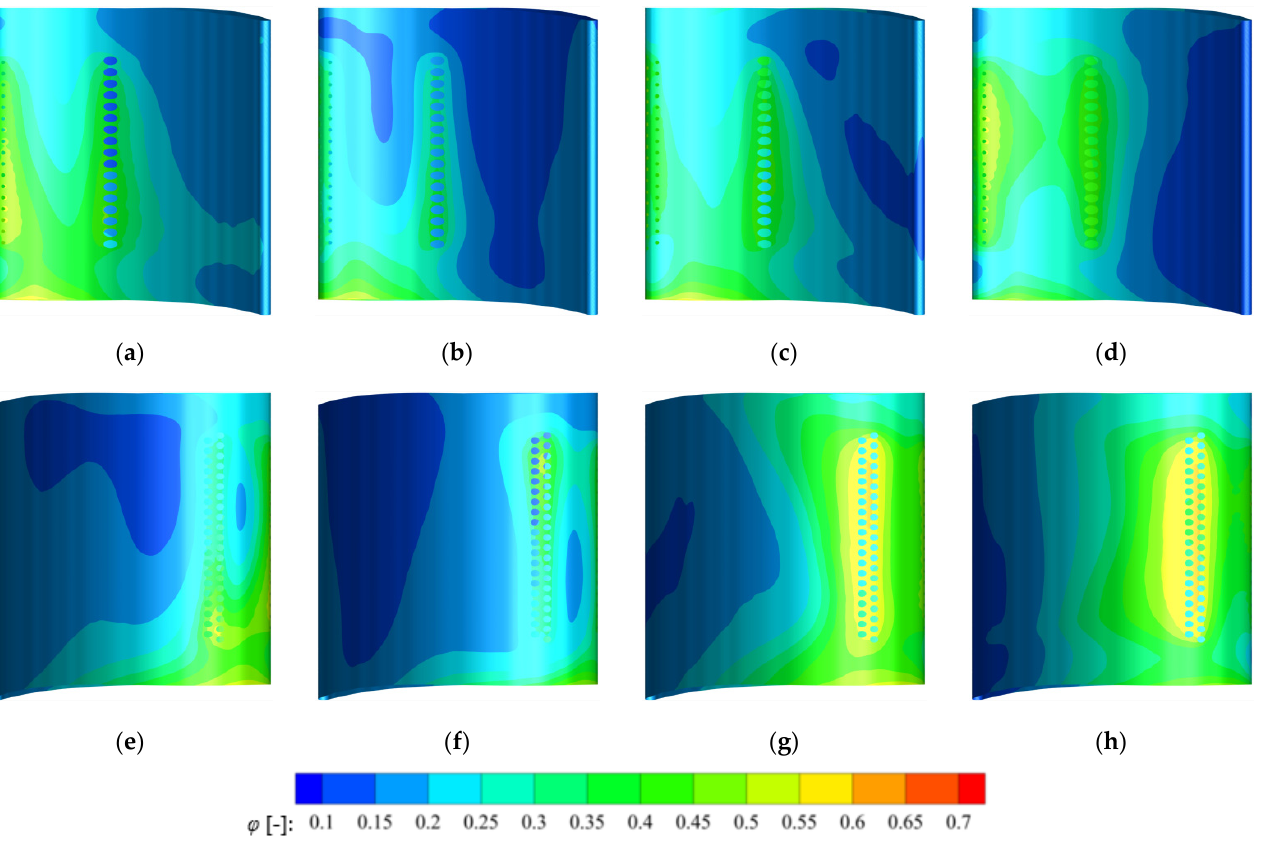
Figure 11. The overall cooling effectiveness of the uncoated blade at different relative stator–rotor locations. ( a ) Pressure Side At 0/4 T ; ( b ) Pressure Side At 1/4 T ; ( c ) Pressure Side At 2/4 T ; ( d ) Pressure Side At 3/4 T ; ( e ) Suction Side At 0/4 T ; ( f ) Suction Side At 1/4 T ; ( g ) Suction Side At 2/4 T ; ( h ) Suction Side At 3/4 T .